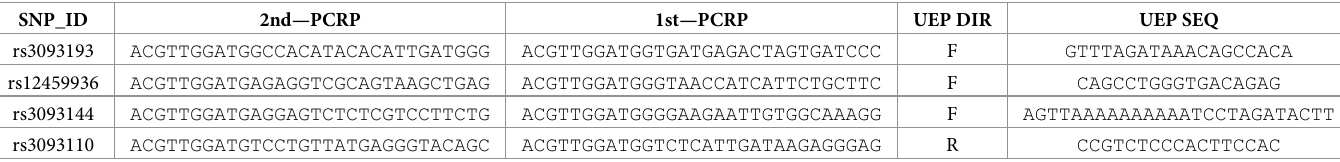
Table 2. Primers used for this study.